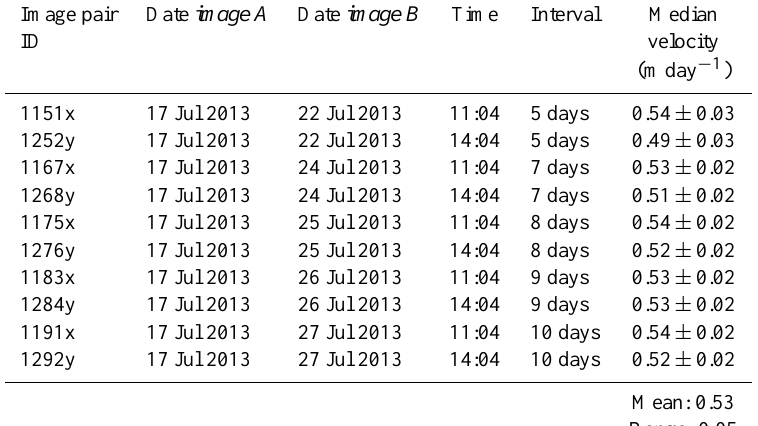
Table 2. Image pair IDs and parameters used in the error calculation based on subset 1, including the median velocity for that image pair . Image